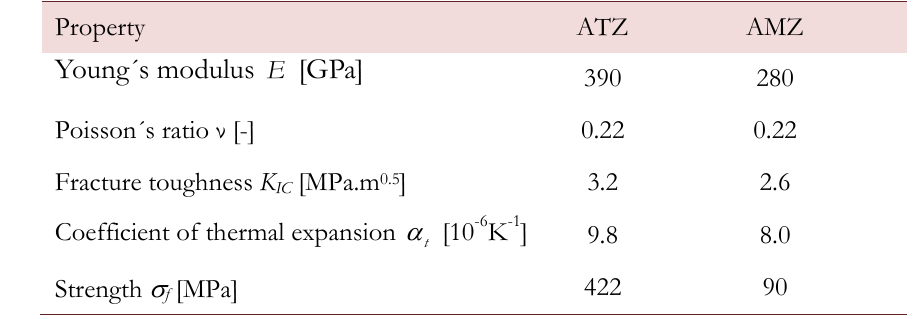
Table 1: Material properties of studied laminate [ 20,21